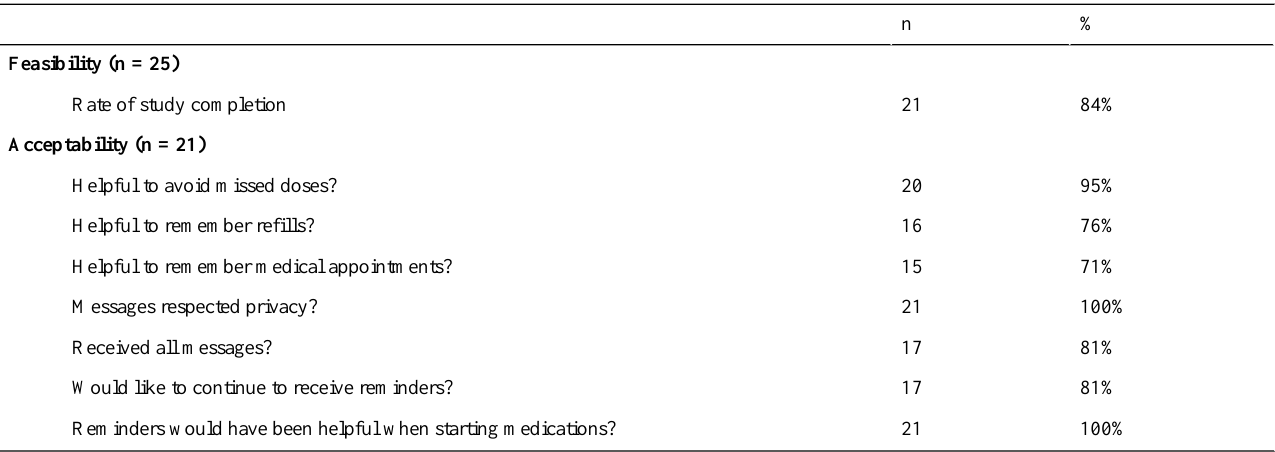
Table 4. Feasibility and acceptability of the study